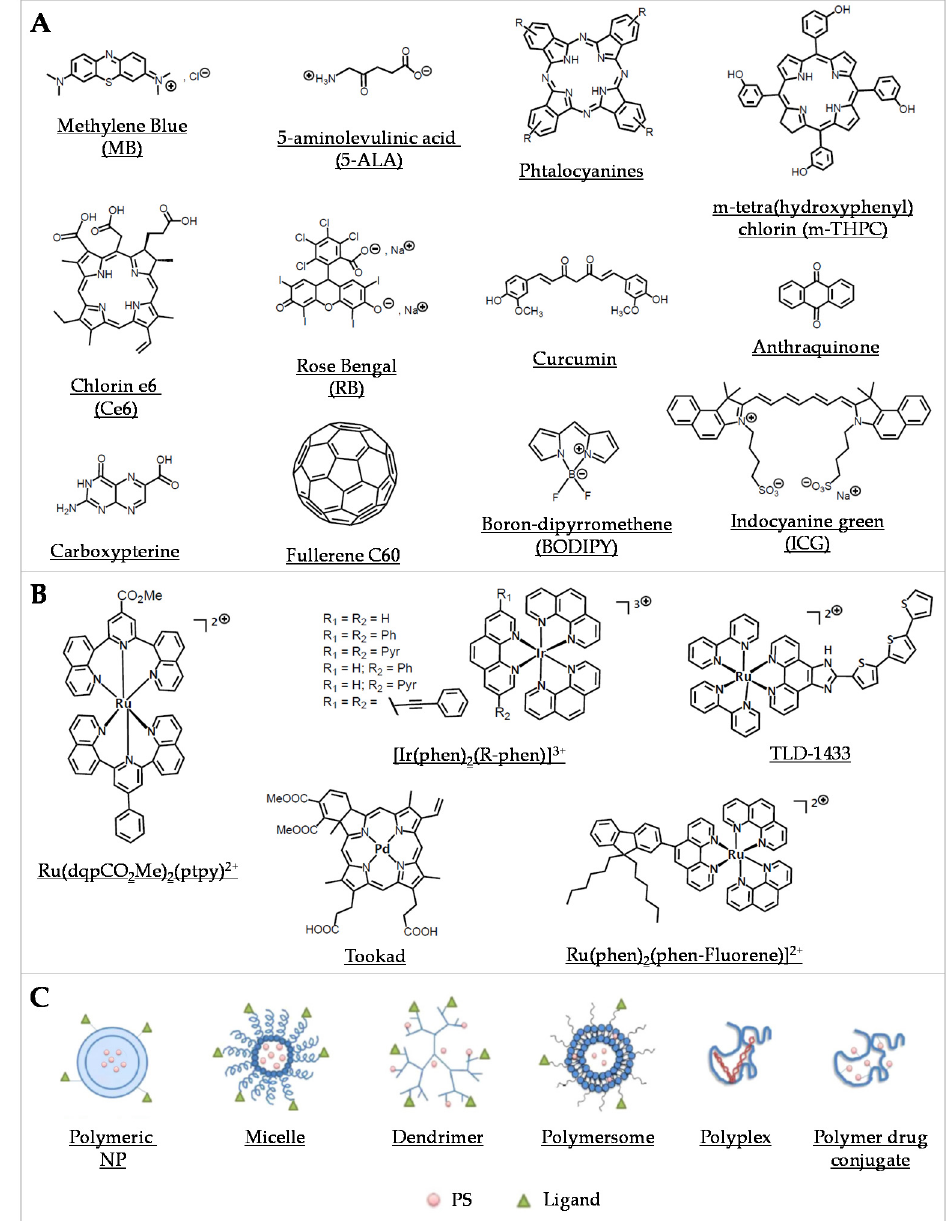
Figure 2. Representative compounds in various classes of PSs used in aPDT. ( A ) Examples of some organic PSs and their derivatives. ( B ) Examples of metallic-based PSs. ( C ) Different types of polymer-based PS carriers, which can be functionalized with ligands for specific target delivery (Adapted from [94], published by MDPI, 2020).